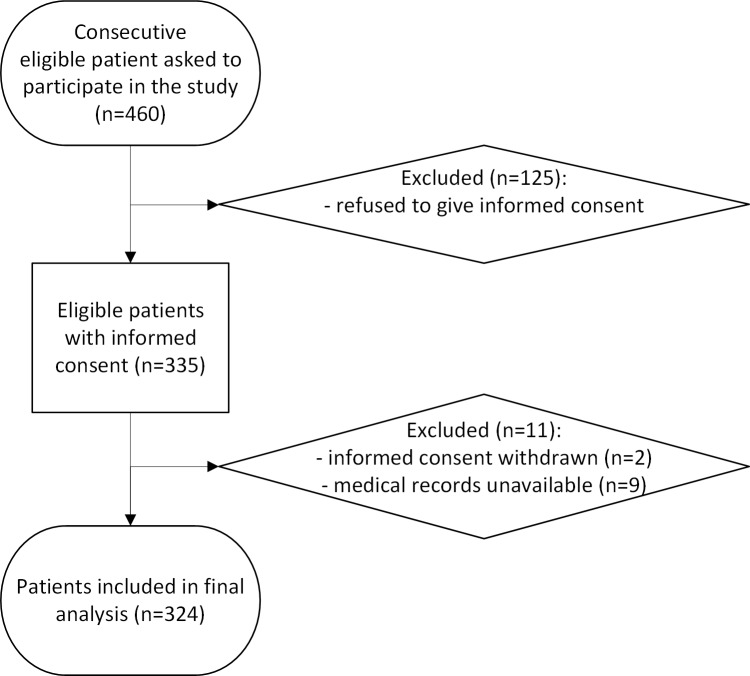
Flow diagram of patient inclusion.